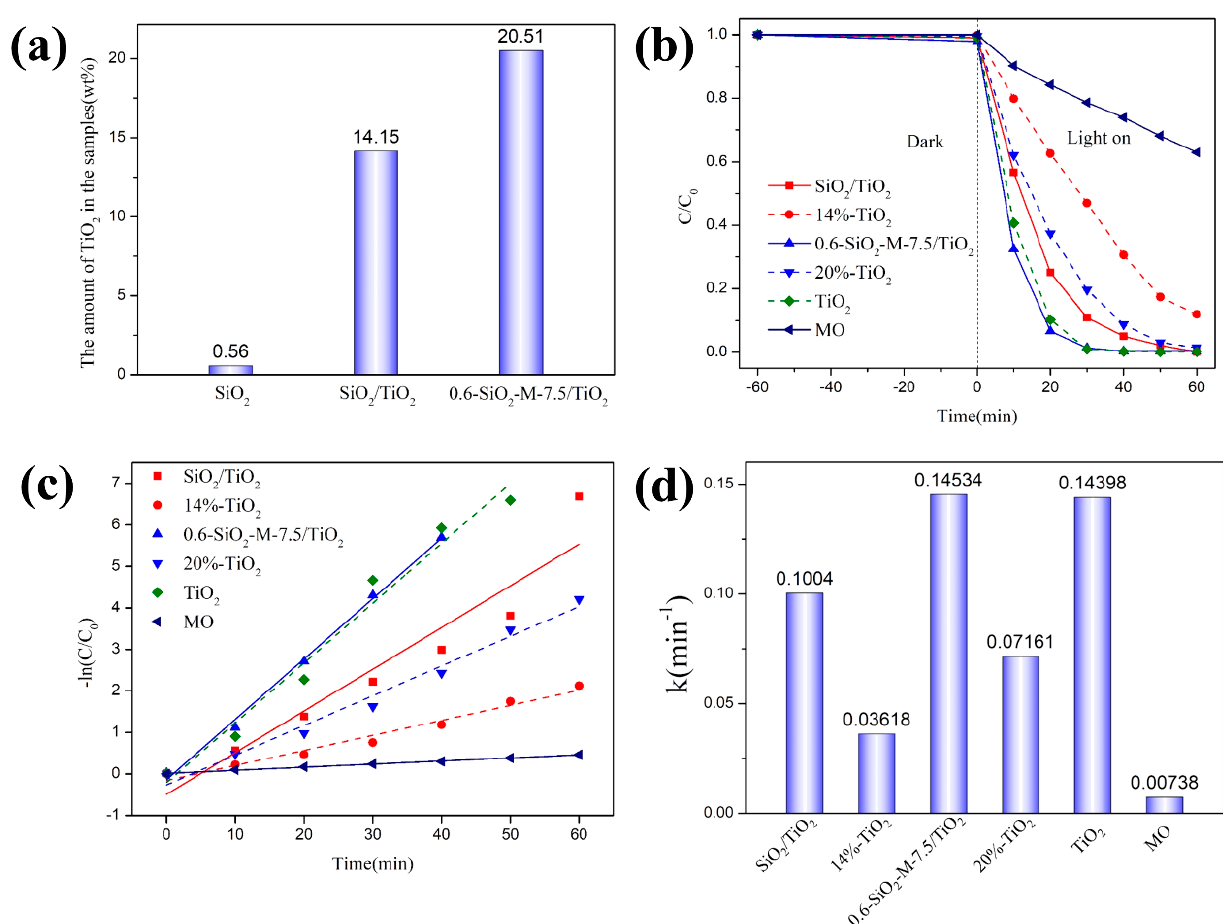
Figure 6. The amount of TiO 2 in SiO 2 , SiO 2 /TiO 2 , and 0.6-SiO 2 -M-7.5/TiO 2 ( a ); photocatalytic degradation of MO of the as-prepared composite as well as the comparative samples under ultraviolet light ( b ); photocatalytic degradation kinetics curve ( c ); apparent reaction rate constants ( d ).